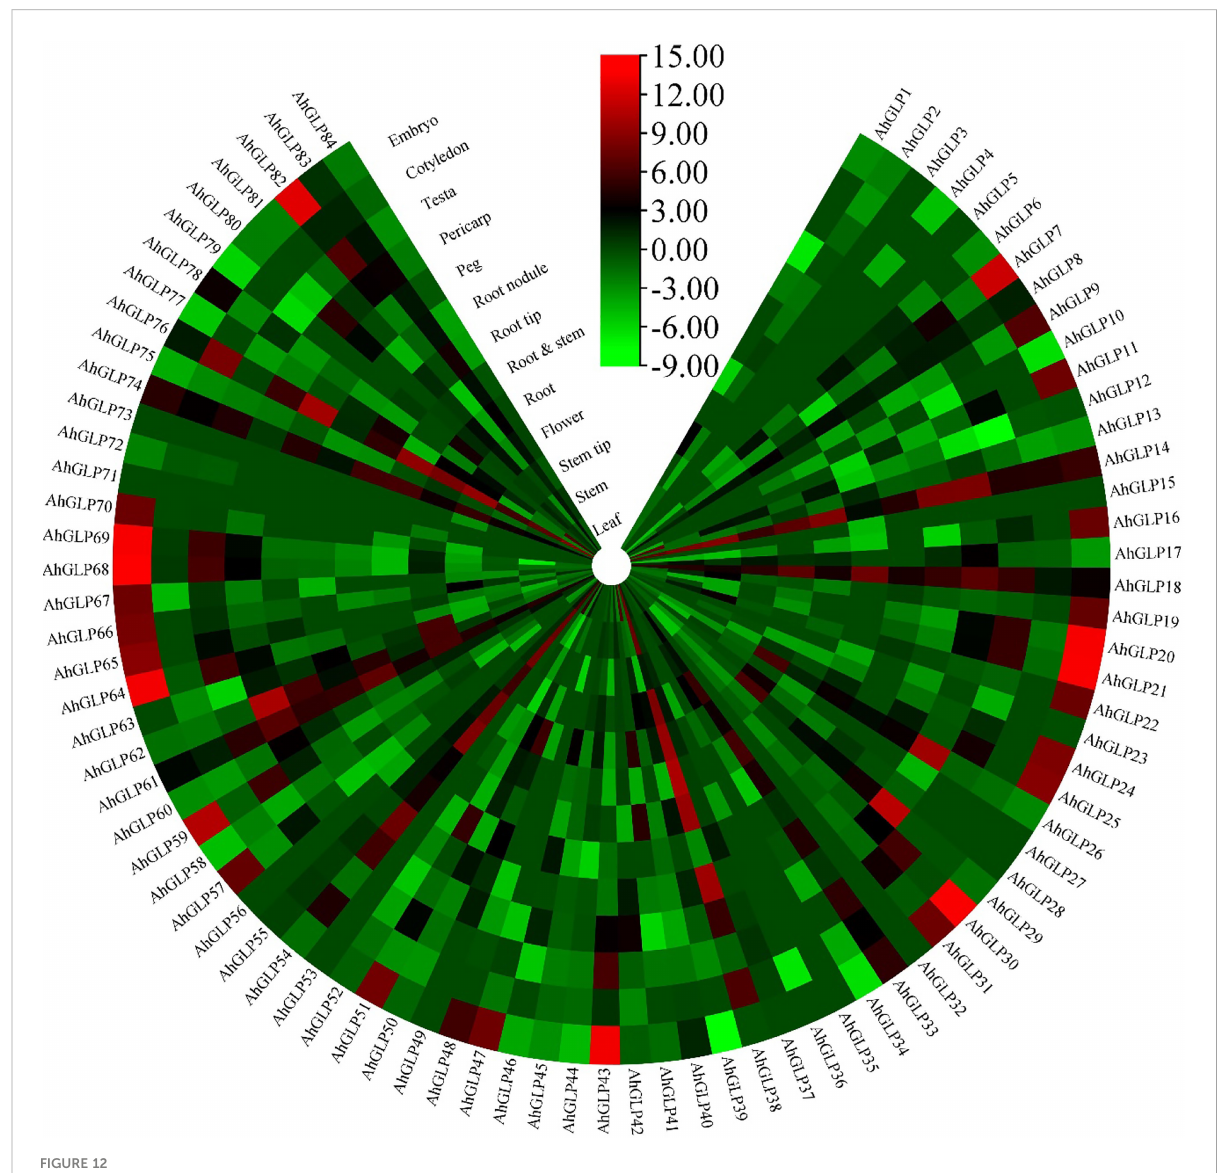
FIGURE 12 Transcriptome expression of AhGLPs in different tissues. AhGLPs possessed varying expression matrices in different tissues. Some genes are very lowly expressed in all tissues, while others are speci fi cally expressed in leaf, pericarp, and